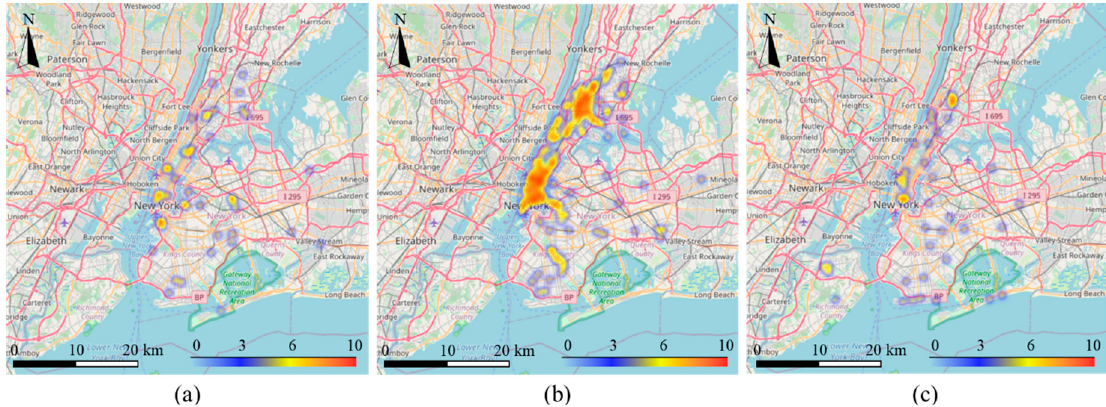
Figure 8. Hotspots of burglary in New York City, NY ( a ) 26 May 2020; ( b ) 2 June 2020; ( c ) 9 June 2020.